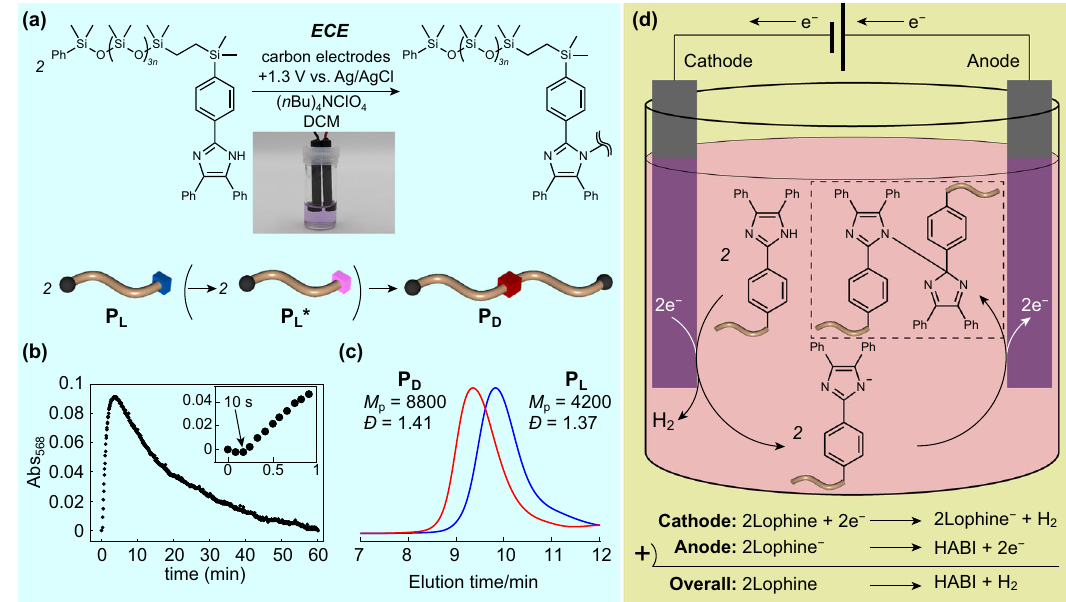
Fig. 4 Electrochemical oxidation of P L . a Synthesis of P D upon applying a potential of 1.3 V to DCM solution of P L containing ( n Bu) 4 NClO 4 with carbon electrodes. The inset photograph shows the pink-colored reaction solution upon applying potential. b Time-course plots of A 568 against time upon electrochemical oxidation of P L . The inset is the magni fi cation of the corresponding time range of 0 – 1 min. c SEC traces of P L (blue line) and P D (red line). d Schematic illustration of the mechanistic aspect with electrochemical oxidation of lophine-appended